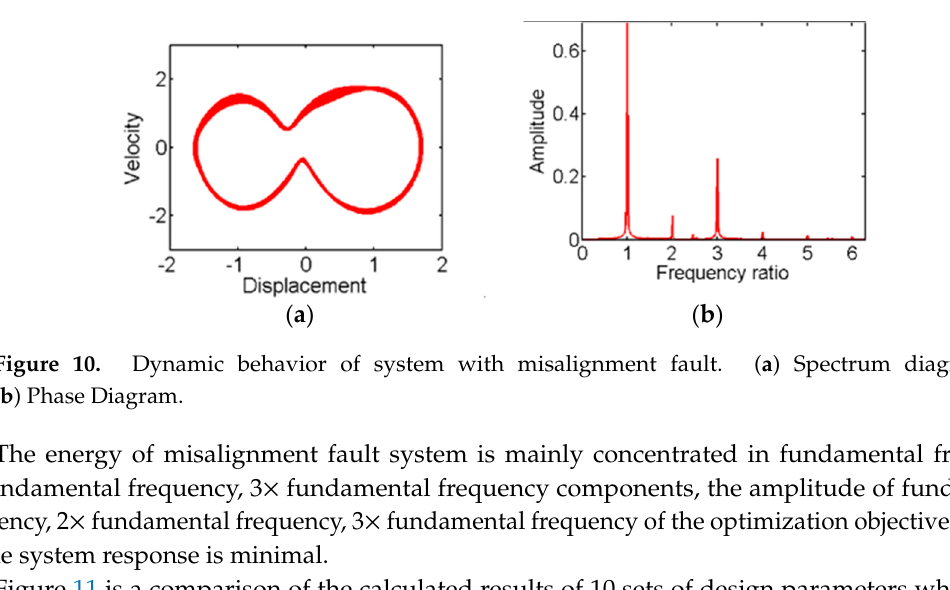
( c ) Figure 11. Comparison between calculated results and approximate model with misalignment fault. ( a ) Fundamental frequency; ( b ) 2× fundamental frequency; ( c ) 3× fundamental frequency. Figure 12 shows the optimization parameters of the oil film gap C S , elastic support stiffness K a and the impact of the viscosity of the lubricating oil μ s on the amplitude of fundamental frequency, 2 × fundamental frequency and 3 × fundamental frequency. From Figure 12, it can be seen that the effect of the three parameters on the system is nonlinear. As a result, fundamental frequency, 3 × fundamental frequency mainly influences the oil film gap C S ; and the 2 × fundamental frequency is mainly influenced by the support stiffness K a .